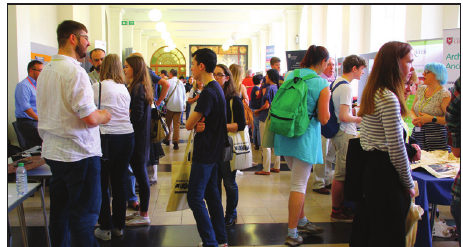
Figure 4: The exhibition area at